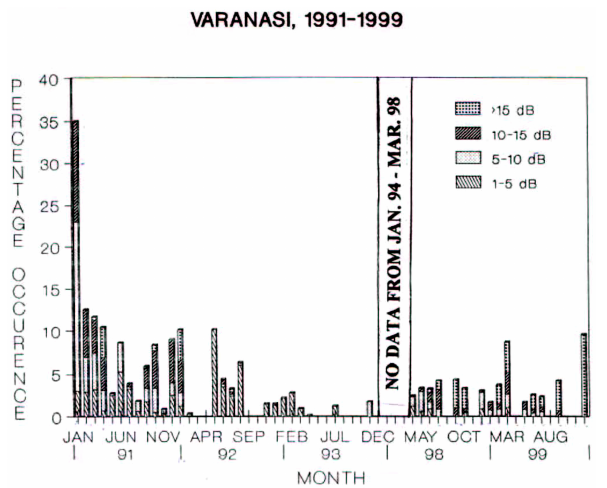
Fig. 2. Percentage occurrence of 15-min fade depth indices (in dB) for nighttime scintillation is given in the figure. The length of the hatching shows the percentage occurrence. For example, in January 1991, the occurrence of scintillations having a fade depth between 10 and 15dB is (35 − 23=12) 12%.